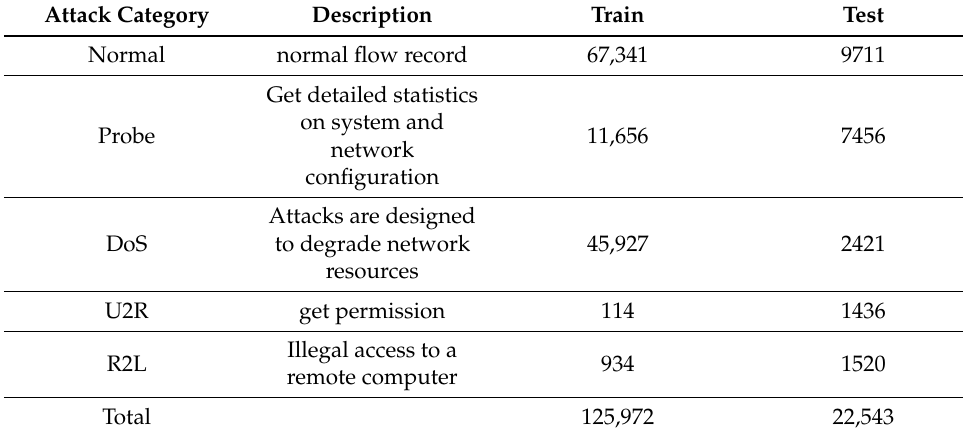
Table 2. Composition of NSL-KDD